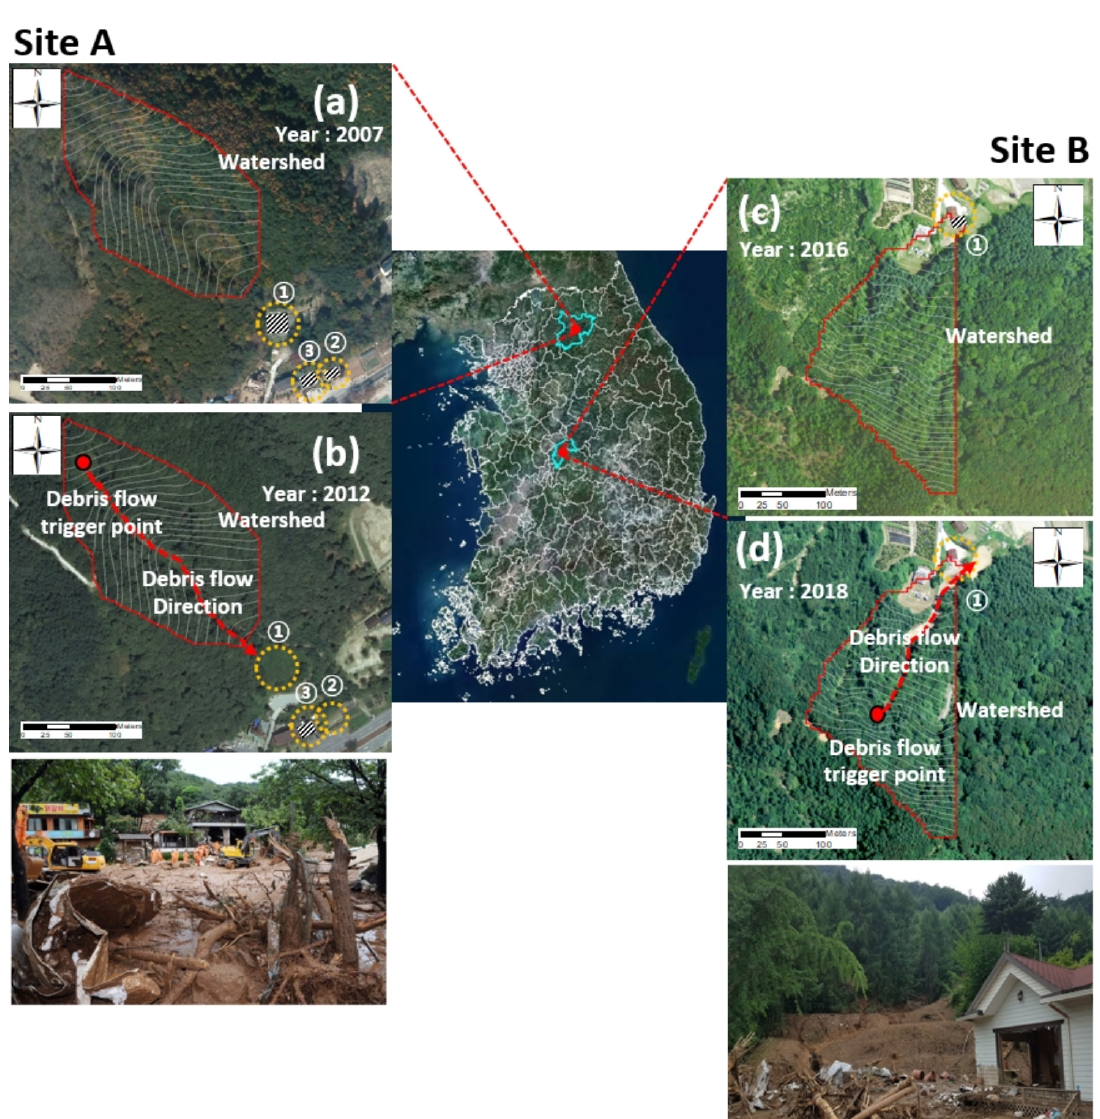
Figure 1. Location of study areas on satellite images. Before ( a , c ) and after ( b , d ) occurrence of debris flows in Chuncheon-shi (Site A) and Cheongju-shi (Site B). In Site A, ① wood structure (completely broken), ② brick masonry structure (completely broken), and ③ brick masonry structure (slightly damaged); and in Site B, ① prefabricated panel structure (completely broken).